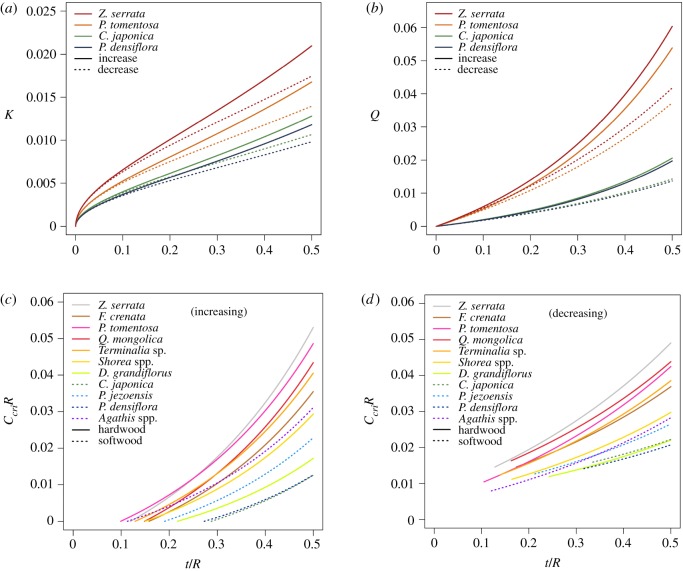
K, Q and ccriR as a function of t/R for various tree species subject to curvature-increasing and curvature-decreasing bending. Equations used to compute the results are equations (2.5) and (2.16) for (a), equations (2.10) and (2.19, for (b), equation (2.11) for (c) and equation (2.20) for (d).